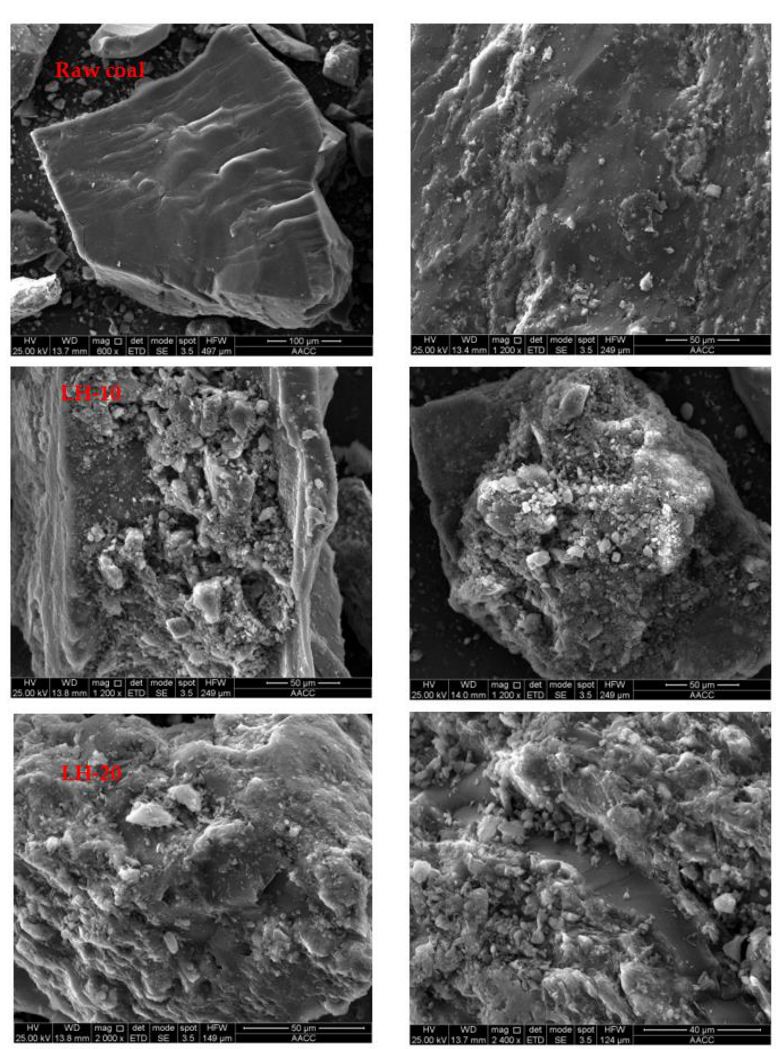
Figure 3. Surface morphologies of coal before and after heating oxidation at 200 °C.